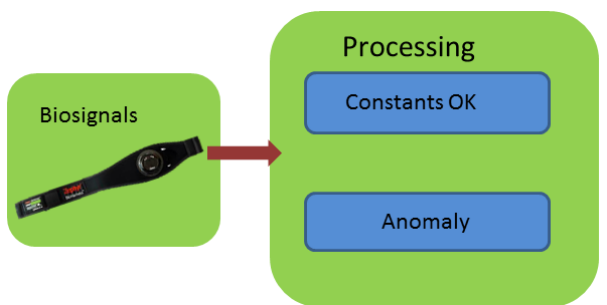
Figure 11. Block B—Anomaly detection.